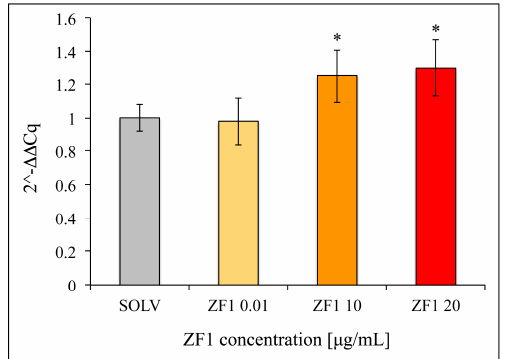
Figure 5. The effect of ZF1 treatment on TERT gene expression in hASCs. The hASCs (culture passages 5 th –7 th ) were exposed for 72 h in the presence of 0.01, 10, and 20 μ g/mL ZF1, or solvent (SOLV) as a control. The expression value of the transcripts evaluated in solvent or ZF1-treated cells was